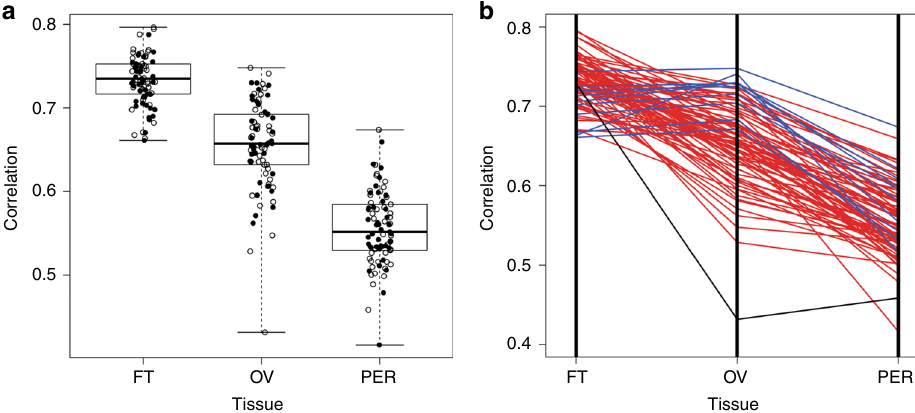
Fig. 7 Correlation between gene expression of tumor samples and normal tissues. The mRNA expression pro fi le for each tumor sample was correlated to prototype pro fi les derived from normal fallopian tube (FT), ovarian surface epithelium (OV) and peritoneal (PER) tissue, respectively, using genes most differentially expressed across normal tissue types. a Correlation coef fi cients for tumor samples compared to each normal tissue type indicated by the presence (solid circles) or absence (open circles) of STIC lesions. Boxplot center lines represent medians, box limits are the inter-quartile range from 25 and 75%, whiskers represent the extent of tumors out to 1.5 times the inter-quartile range. b Plot of correlation coef fi cients for each sample across normal tissue types. Each line corresponds to an individual tumor sample. Seventy- fi ve of eighty- fi ve tumor samples (88%) were most closely correlated with the normal fallopian tube phenotype (red lines). The remaining 10 (blue lines) more closely resembled the normal ovarian tissue. Normal peritoneum tissue had the lowest correlation with all but one sample